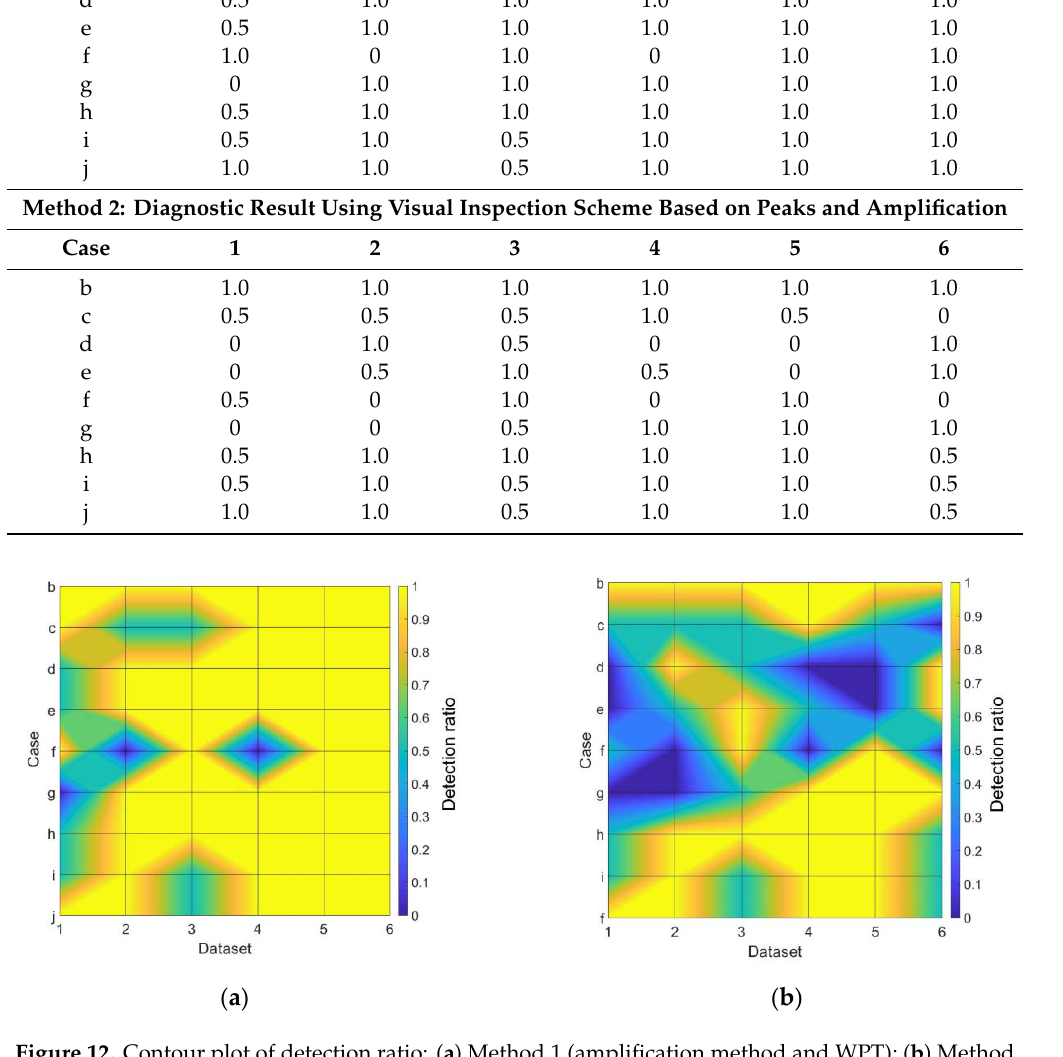
Figure 12. Contour plot of detection ratio: ( a ) Method 1 (amplification method and WPT); ( b ) Method 2 (amplification method